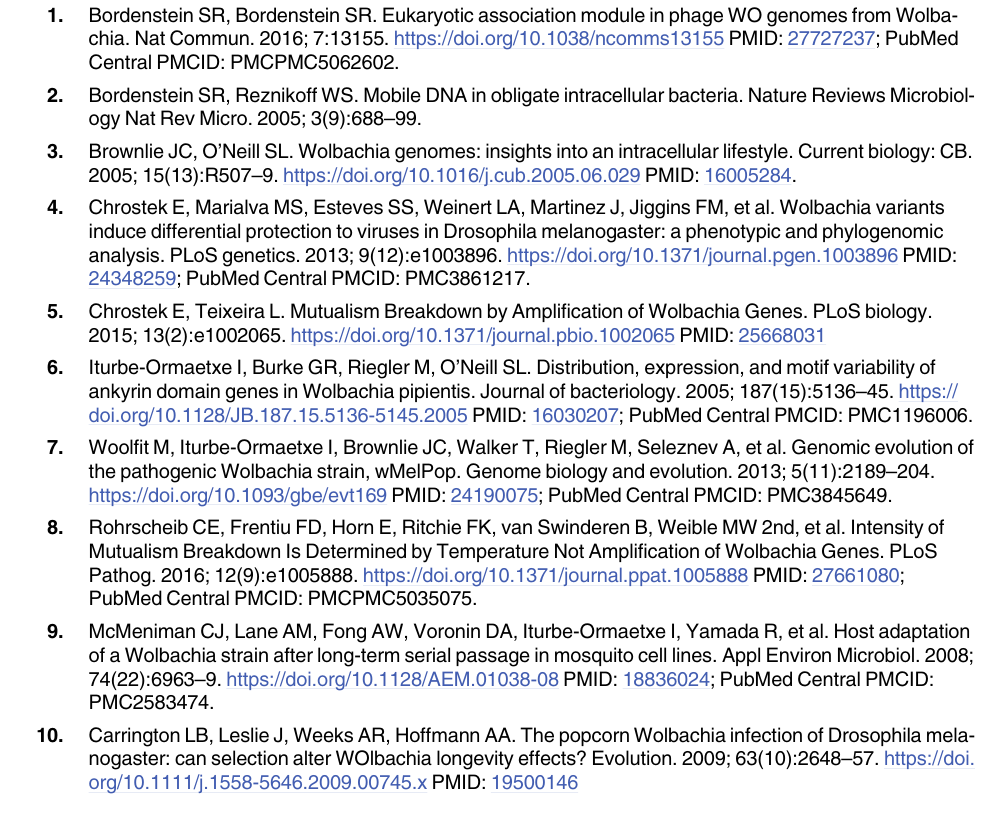
S1 Data. Raw density data. Raw Wolbachia density data for flies infected with w MelCS reared at different temperatures and across different time